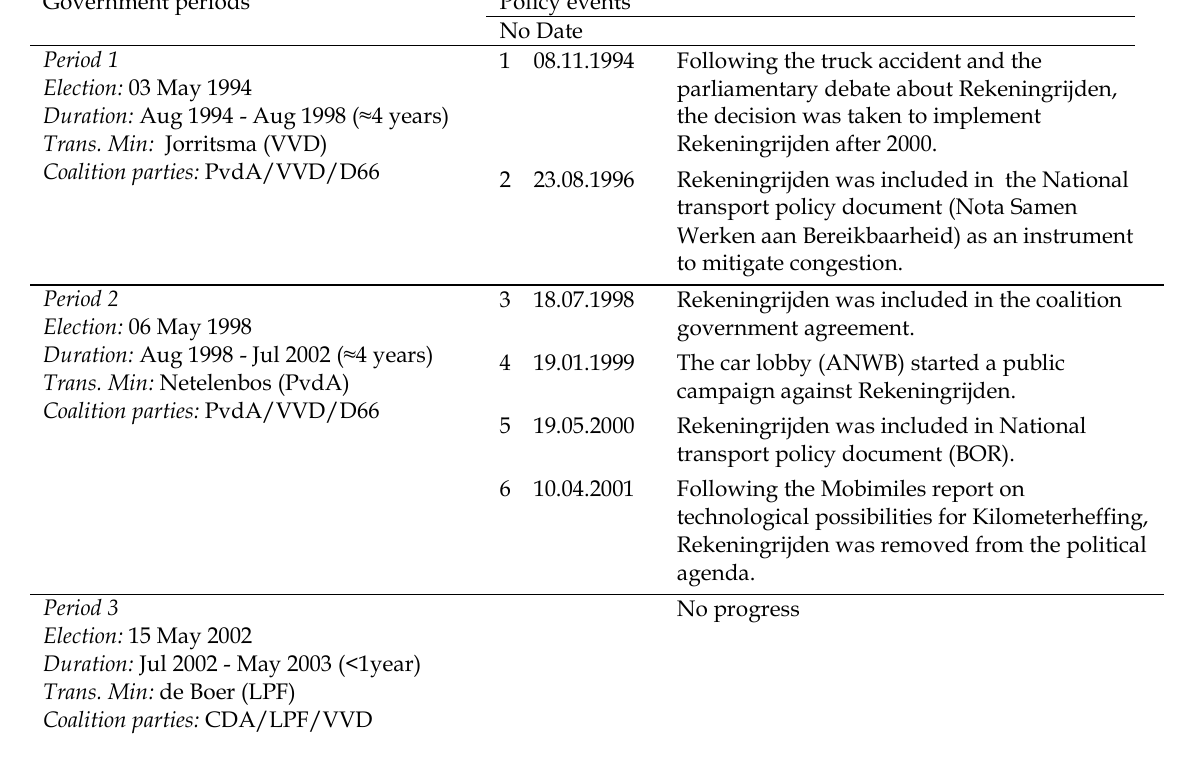
Table 1. Government periods and major policy events between 1994 and 2010 Government periods Policy